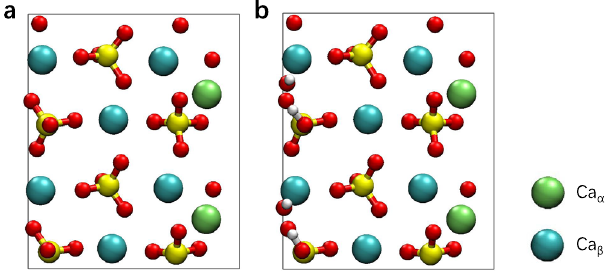
Fig. 1 The top view of the initial Ca 3 SiO 5 (111) surface model. a The top view of the surface before protonation. b The top view of the surface after protonation. The green, cyan, yellow, red, and white spheres are indicted to the three-coordinated Ca α species, the fi ve-coordinated Ca β species, the silicon, oxygen, and hydrogen